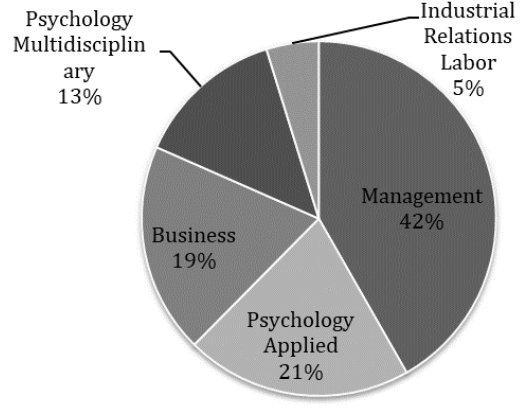
Figure 3. Five literary domains of 190 articles.